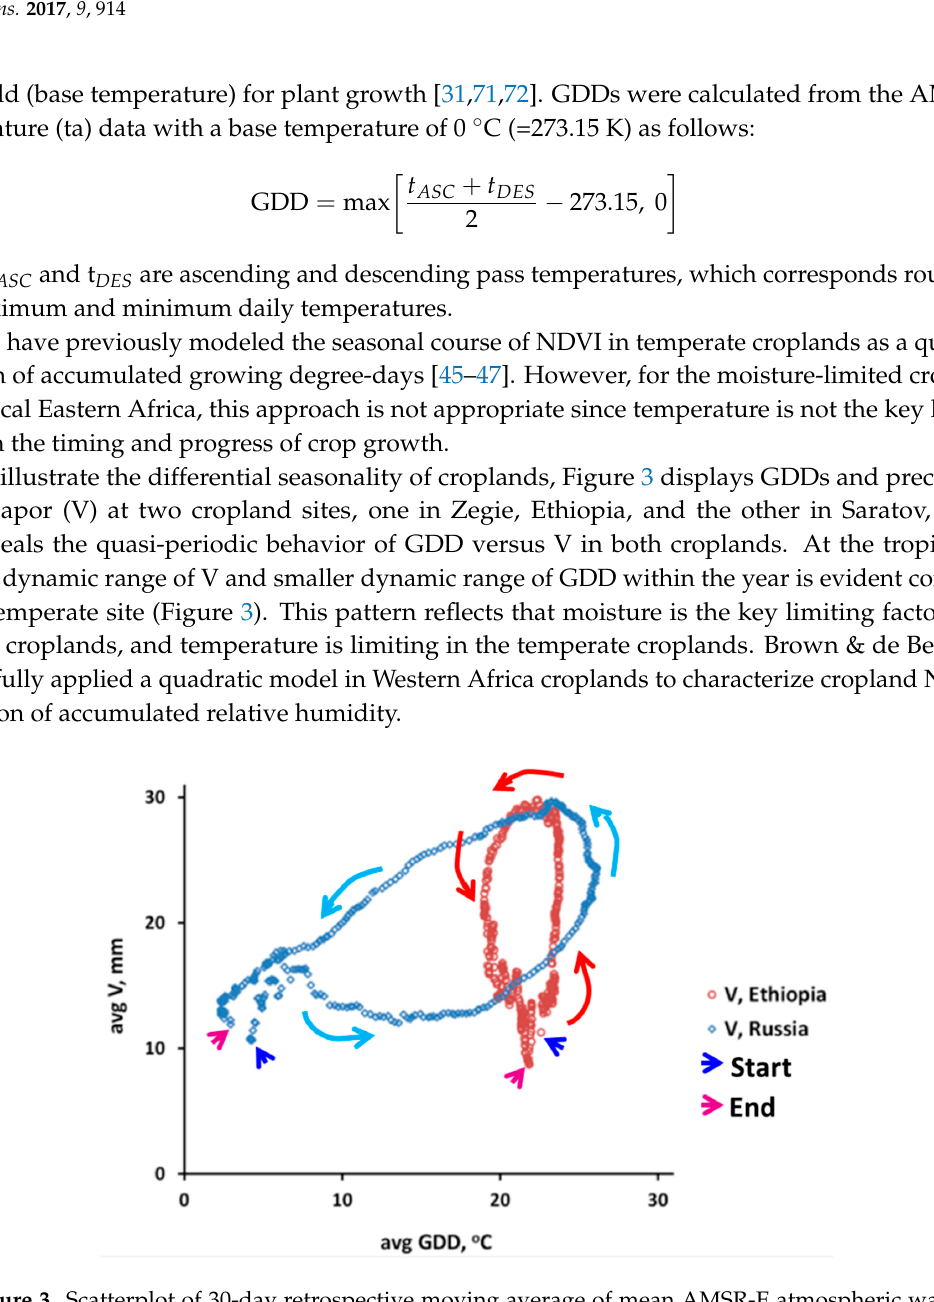
Figure 3. Scatterplot of 30-day retrospective moving average of mean AMSR-E atmospheric water vapor (V) as a function of average growing degree-days (GDDs) for Zegie, Ethiopia (maroon circles), and Saratov, Russia (blue diamonds), for the 2003–2010 period. Blue arrows indicate initial points in January, while magenta arrows indicate endpoints of the annual cycle in December. Red arrows show intra-annual cycles of V for Zegie, ET, and cyan arrows for Saratov, RU. Note the relative dynamical range of the variables.